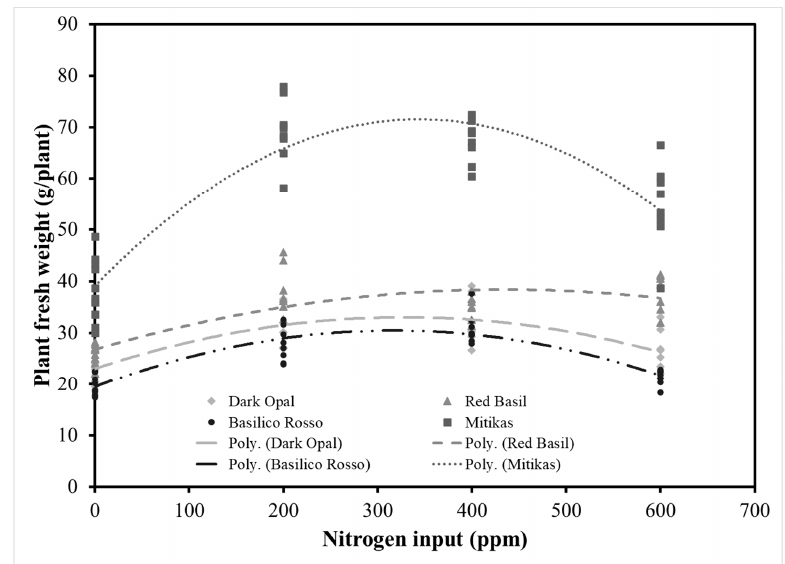
Figure 1. Above-ground plant fresh weight in response to nitrogen input in Dark Opal, Red Basil, Basilico Rosso, and Mitikas. Parameters of the quadratic response curve and their significance are presented in Table